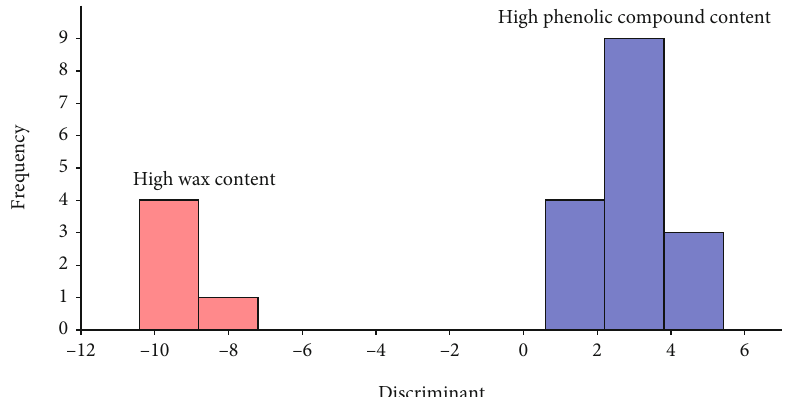
Figure 1: Histogram of canonical discriminant function considering the content of wax and phenolic compounds in propolis